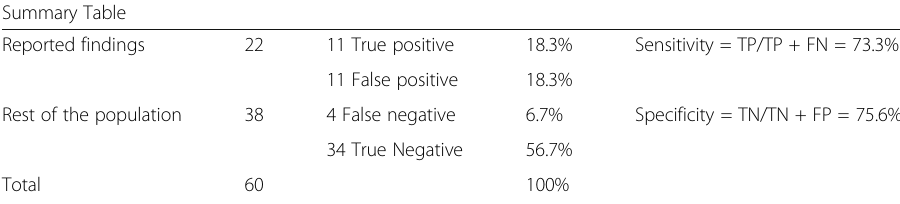
Table 1 Summary of patient distribution. In this table it is shown in detail the distribution of patients according to the four possible categories: true positive, false positive, true negative and false negative. On the right there sensitivity and specificity are